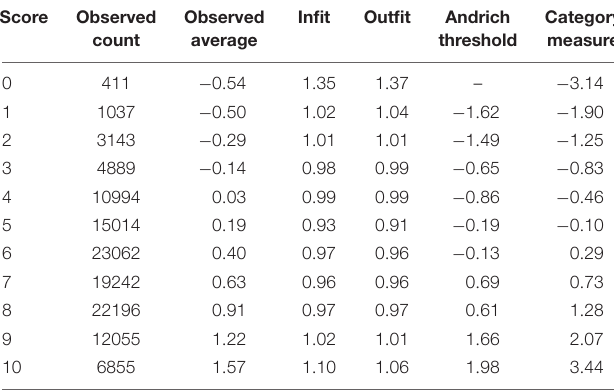
TABLE 3 | Summary of category